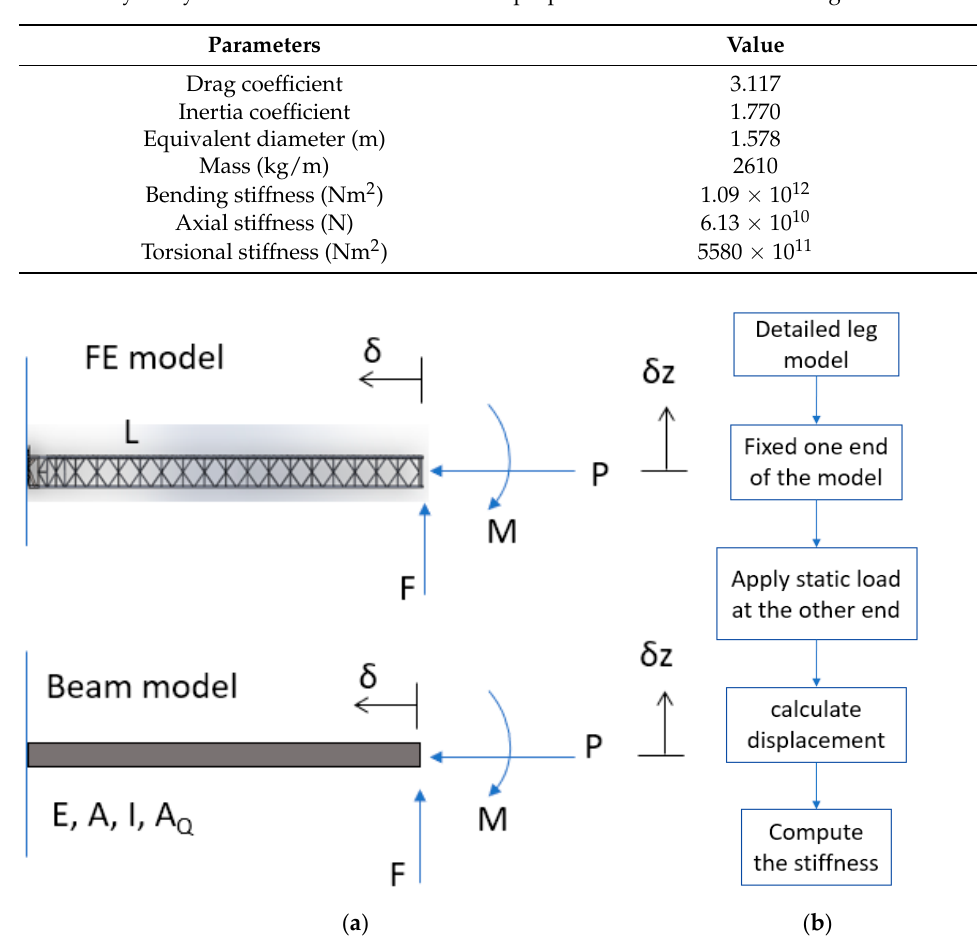
Table 2. Hydrodynamic coefficient and structural properties for the stick model legs.